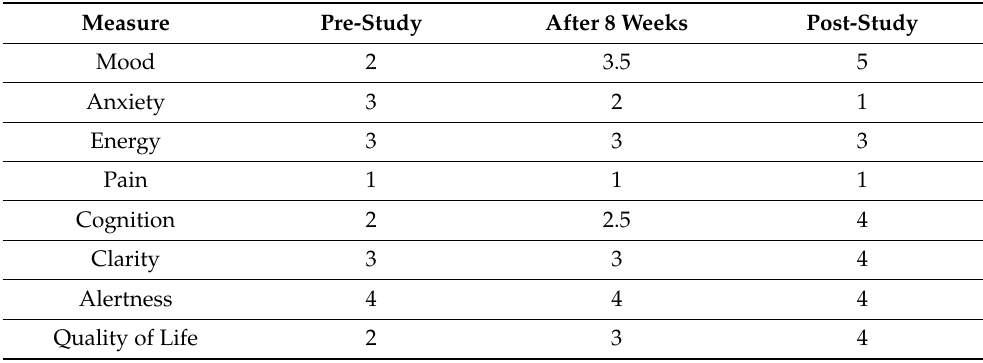
Table 2. Case Two: Likert Scale